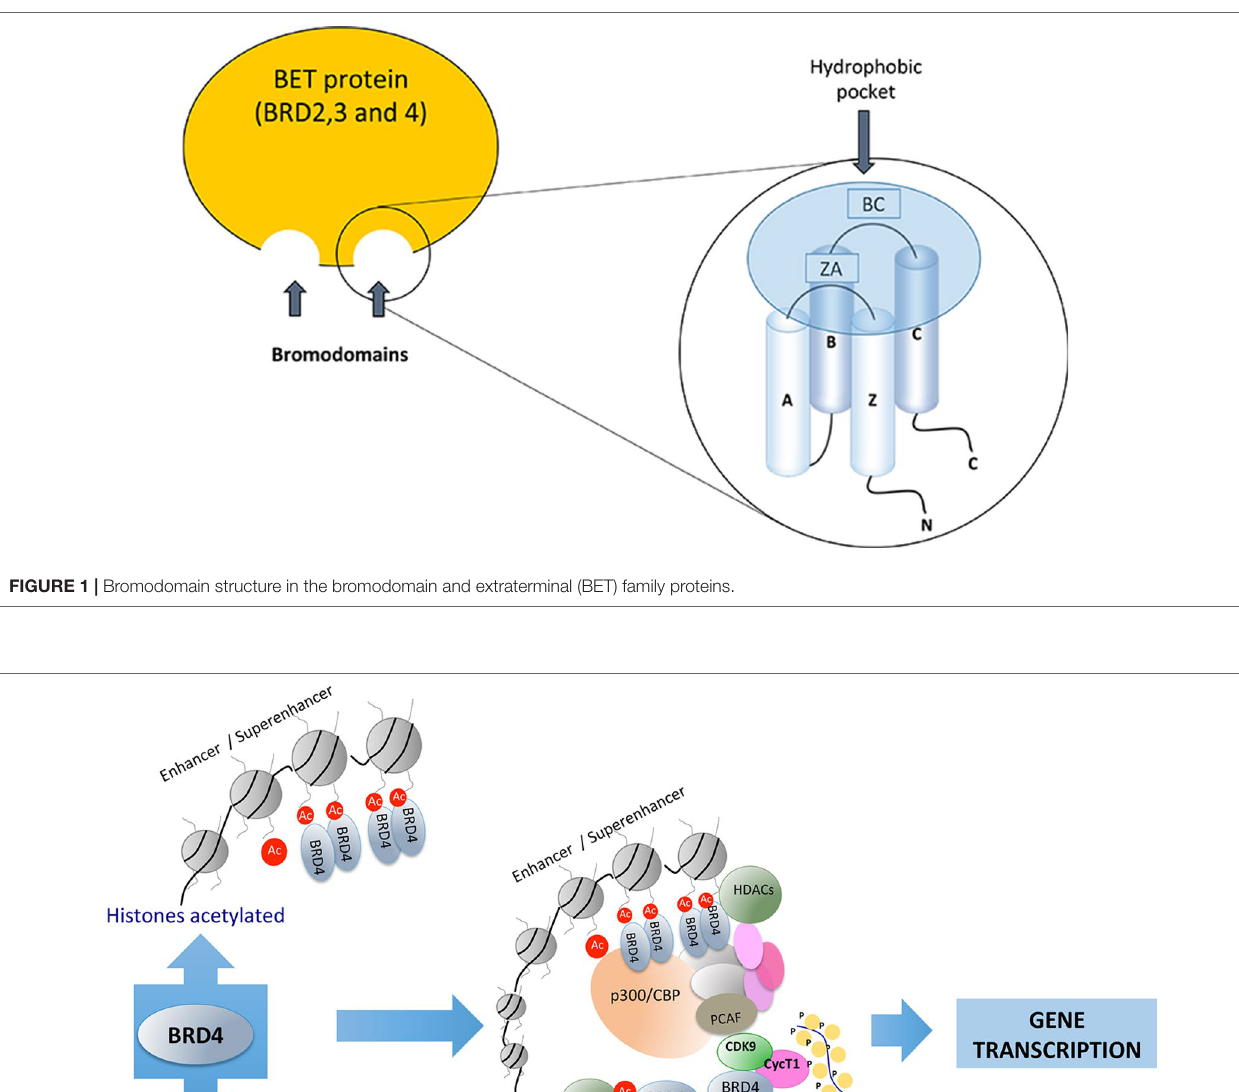
Frontiers in Pharmacology |